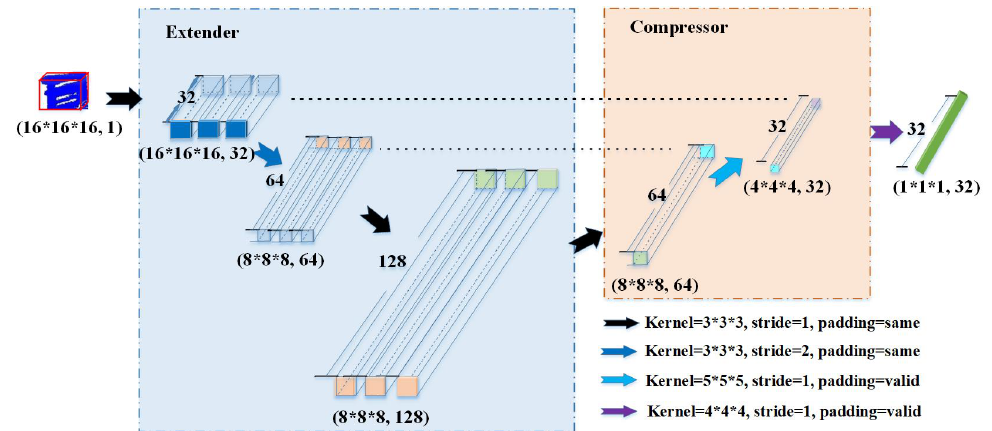
Figure 3. The network structure hierarchy diagram of KdO-Net. Each convolutional layer is followed by batch normalization and ReLu except for the last convolutional layer. The numbers in the bracket denote the size and depth of the feature descriptor extracted through convolutional